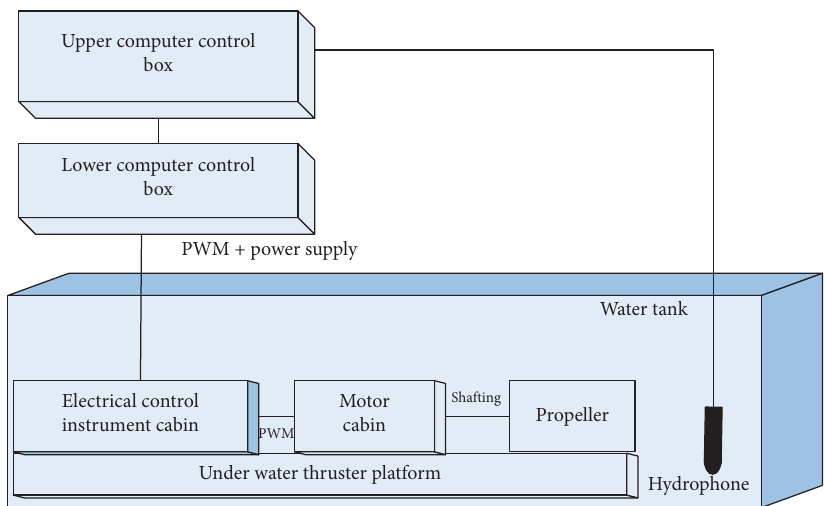
Figure 1: Composition of fault diagnosis device for underwater thruster.